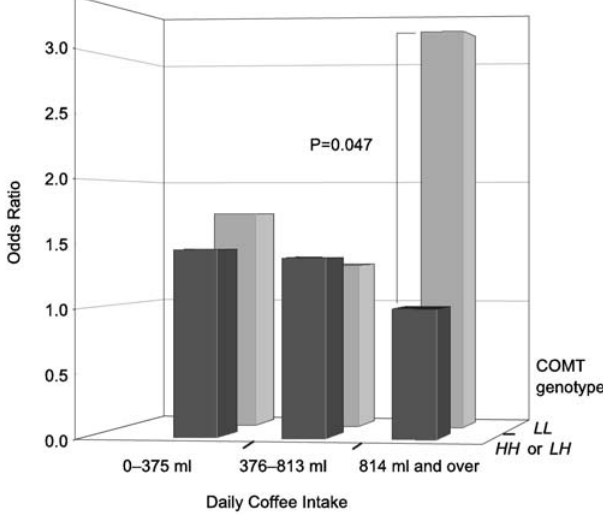
Figure 1. Odds ratios of acute coronary events in 773 men initially free from CHD by joint categories of coffee intake and COMT genotype; predicted from a logistic model with age, smoking, family history of CHD, plasma vitamin C concentration, systolic blood pressure, serum HDL and LDL cholesterol concentration, and diabetes as covariates. doi:10.1371/journal.pone.0000117.g001 PLoS ONE |